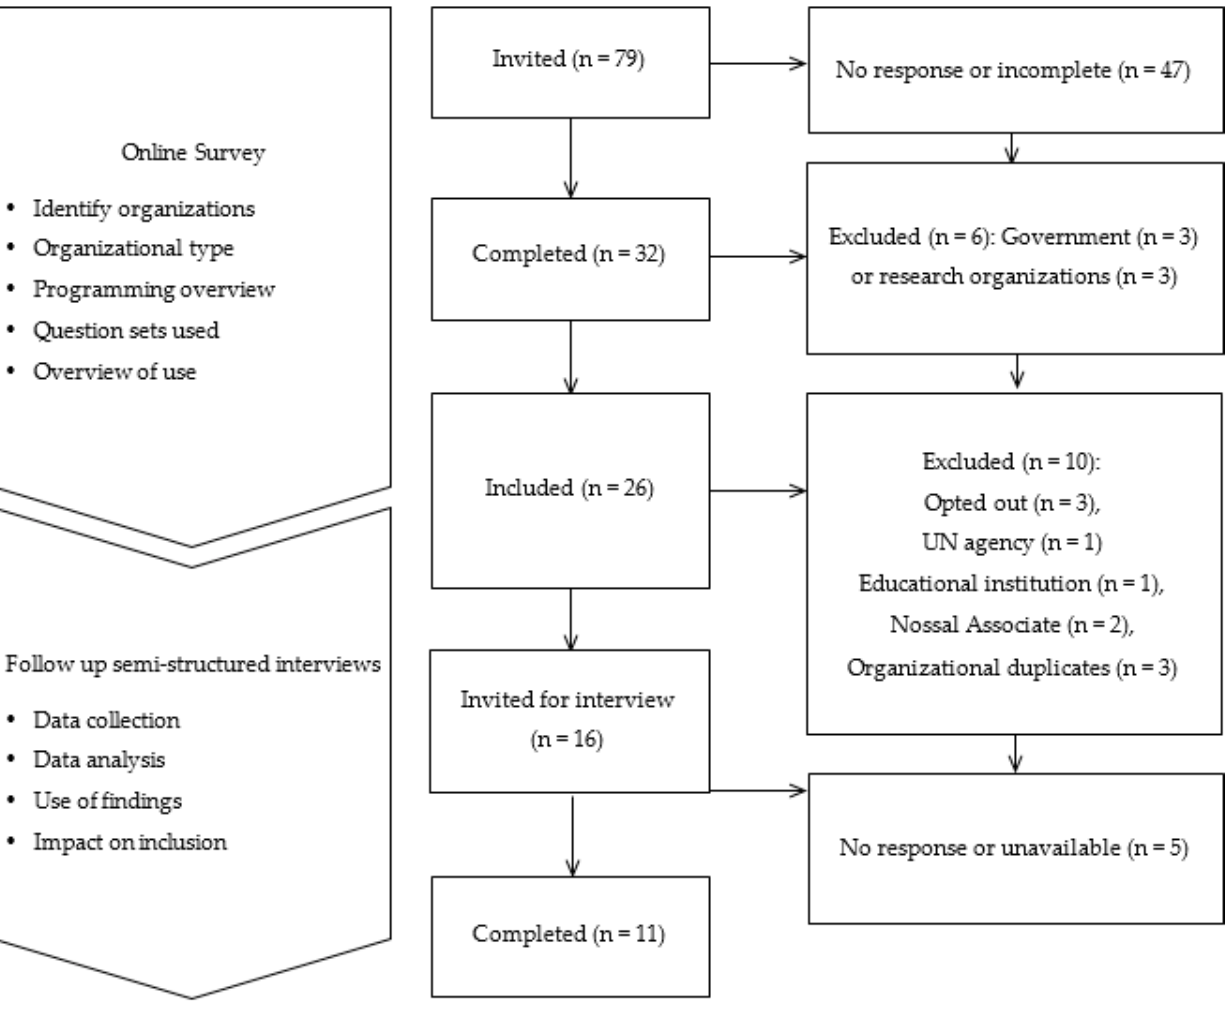
Figure 1. Research process.